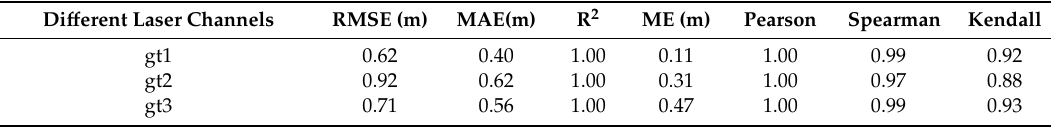
Table 7. The statistical indicators for di ff erent laser pointing